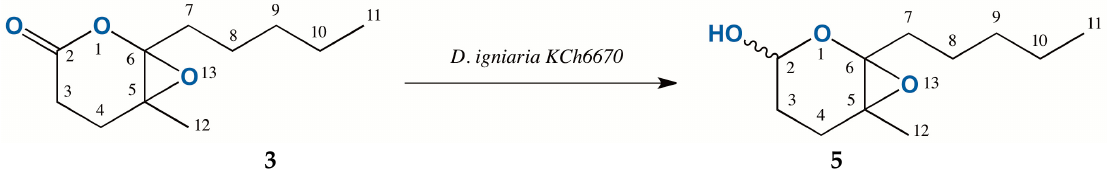
Figure 4. Biotransformation of ( 3 ) with D. igniaria KCh6670.